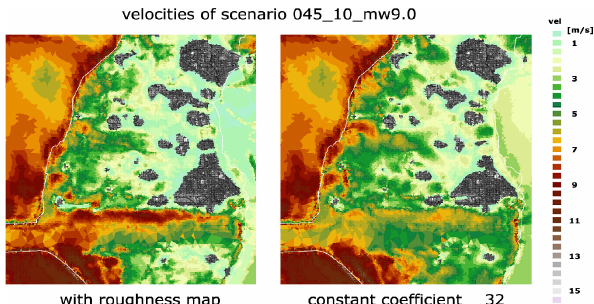
Fig. 9. Maximum velocities for the same scenario as in Fig. 8.